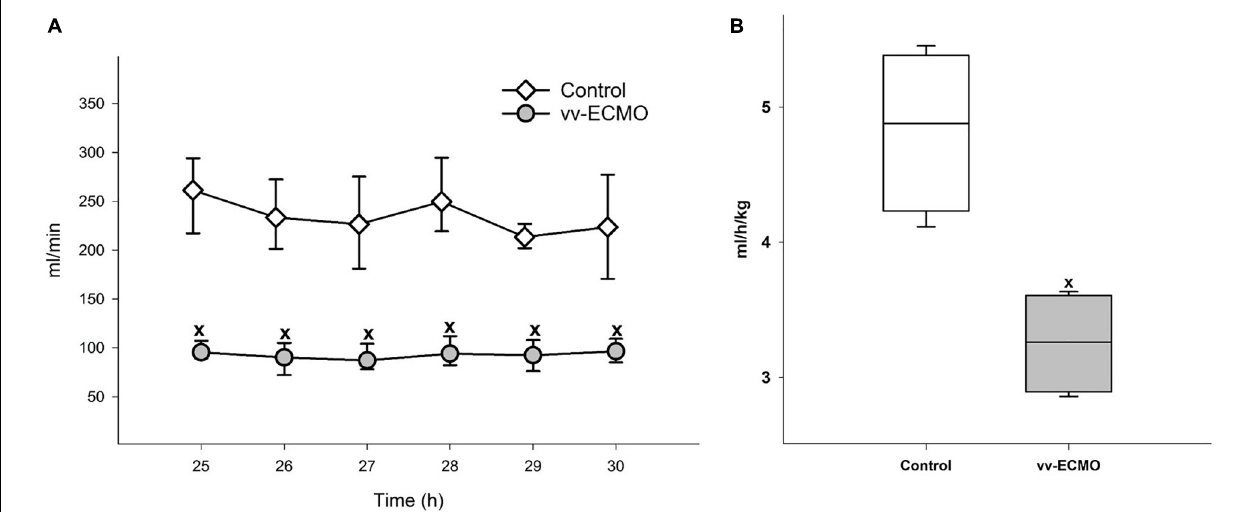
FIGURE 3 | Changes in renal artery flow (A) in the control group (empty diamonds joined by a thin continuous line) and vv-ECMO group (gray circles joined by a continuous line). The plots demonstrate the median and the 25th (lower whisker) and 75th (upper whisker) percentiles. x P < 0.05 for the vv-ECMO vs. control group values (Mann–Whitney test). Changes in average hour diuresis (B) in the control group (empty box) and vv-ECMO group (striped gray box). The plots demonstrate the median (horizontal line in the box), the 25th and 75th percentiles, and the range of data (whiskers). x P < 0.05 for the vv-ECMO vs. control group values (Mann–Whitney